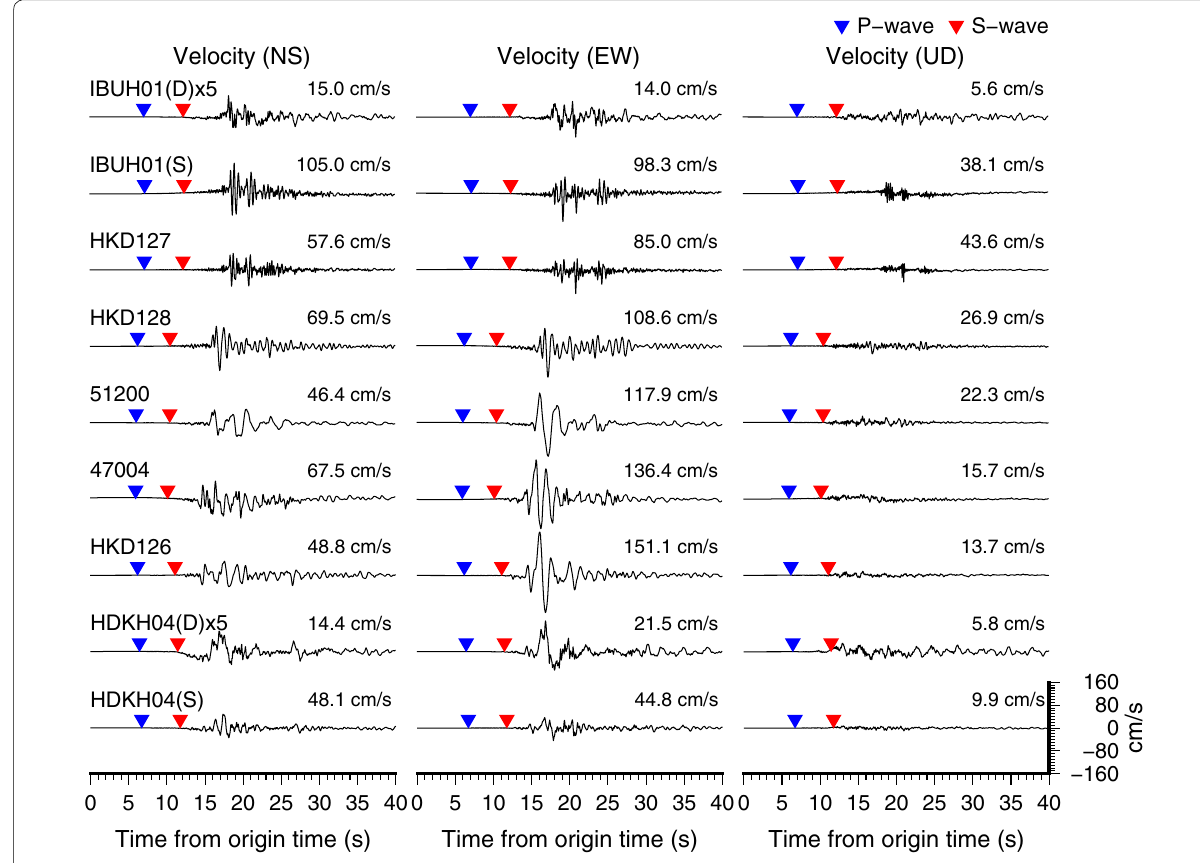
Fig. 2 Observed velocity waveforms at strong-motion stations in the near-source area. The blue and red inverse triangle indicates P- and S-wave onset, respectively. For the KiK-net stations, (D) and (S) denote the downhole and the surface sensor, respectively. The amplitude of the downhole sensor is enlarged by five times in this figure. The locations of these stations are shown in Fig. 1b. The frequency range is 0.05–20